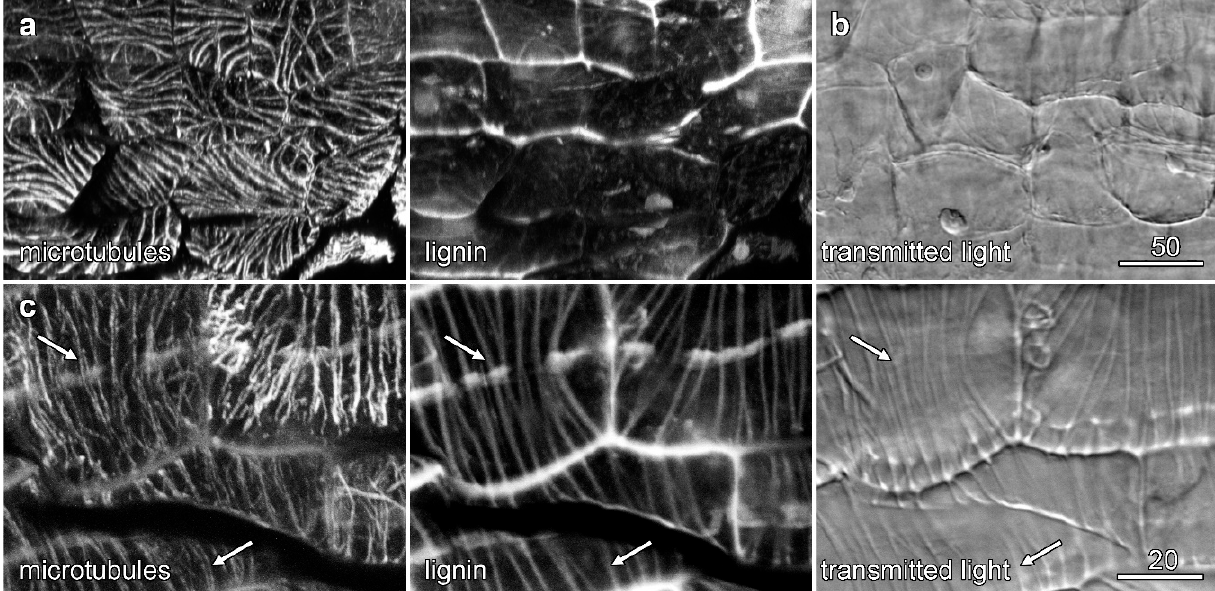
Figure 8. Microtubules and velamen development in Laelia . Labelling of the outermost layer of the velamen was achieved using cell wall digestion enzymes. Confocal maximum projections of microtubules (left-hand column) and lignin autofluorescence (central column), along with concurrent transmitted light images (right-hand column). ( a , b ) Early in development, microtubules have become bundled, and while cell wall ridges were visible in transmitted light, they had not become lignified. Microtubules ran parallel to the wall ridges as single bundles. Confocal images of lignin and microtubules ( a ) were reoriented so that the outer cell layers lie in the image plane, while the transmitted light image ( b ) remains unrotated. ( b ) Once cell wall ridges had developed lignification, the microtubule bundles split to run on either flank of the ridges (arrows). Bar in ( a ) = 50 µm for ( a , b ); bar in ( c ) = 20 µm.